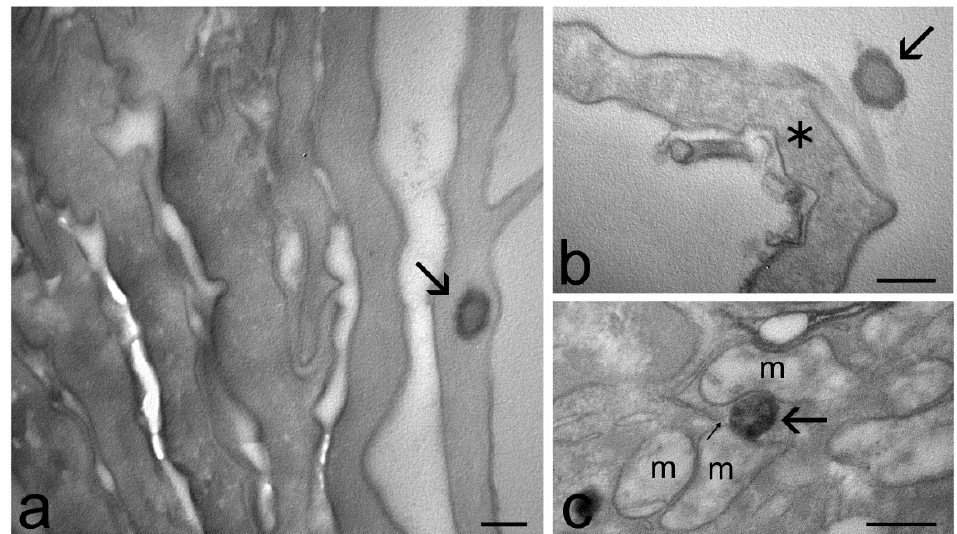
Figure 5. TEM micrographs of TET-1 in the skin. ( a ) A TET-1 (arrow) has been internalized into a corneocyte. ( b ) A TET-1 (arrow) occurs in the intercellular space of the stratum corneum, close to a corneocyte (asterisk). ( c ) A partially degraded TET-1 (arrow) inside a keratinocyte is located very close to smooth endoplasmic reticulum cisternae (thin arrow) and mitochondria (m). Bars: 200 nm. TET-2 were rarely found only in the stratum corneum after 1 h or 3 h of incubation (Figure 6).